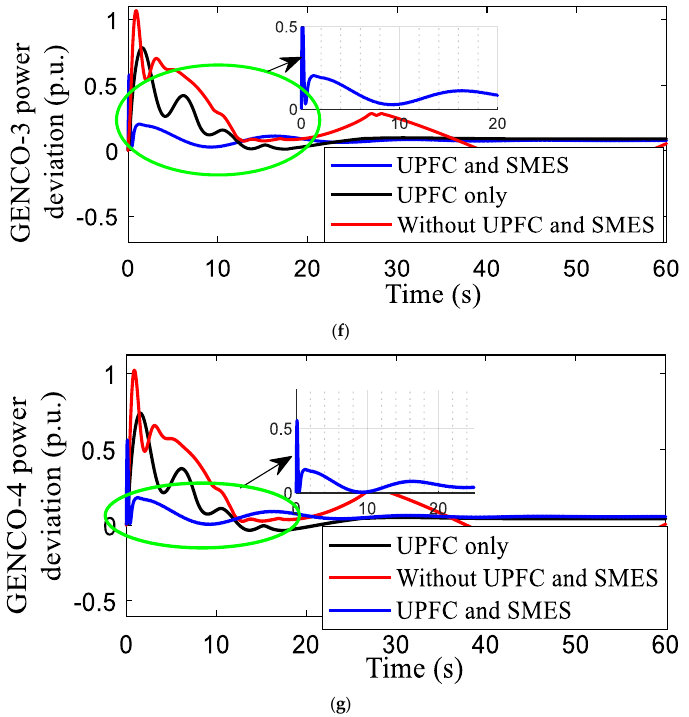
Figure 13. Dynamic performance of Test 3: ( a ) frequency deviation in area-1; ( b ) frequency deviation in area-2; ( c ) tie-line power deviation; ( d ) GENCO-1 power deviation; ( e ) GENCO-2 power deviation; ( f ) GENCO-3 power deviation; ( g ) GENCO-4 power deviation.